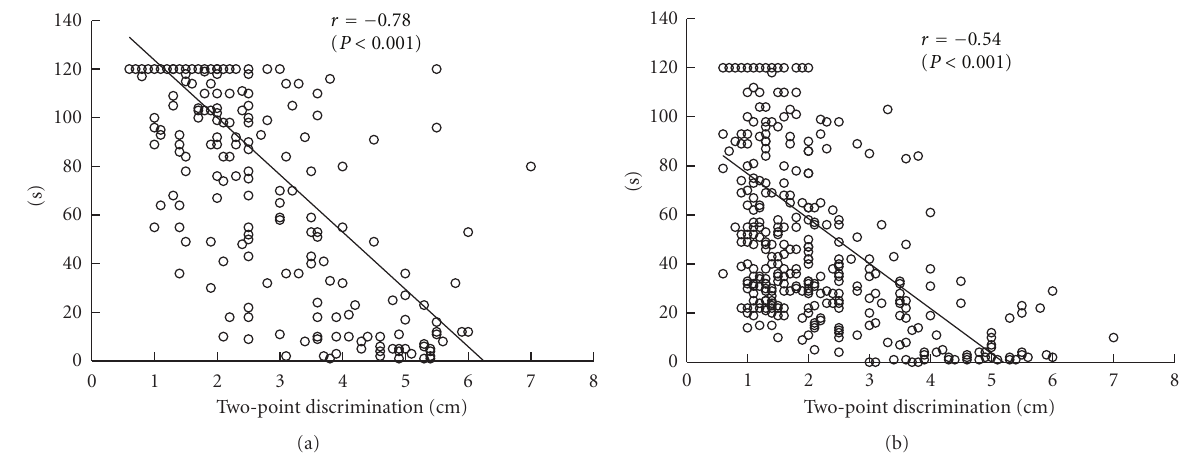
Figure 4: Relation between standing time on one leg and two-point discrimination ( n = 579). There were significant negative correlations between open eyes (a) and two-point discrimination ( r = − 0 . 78, P < 0 . 001) and between closed eyes (b) and two-point discrimination ( r = − 0 . 54, P < 0 .